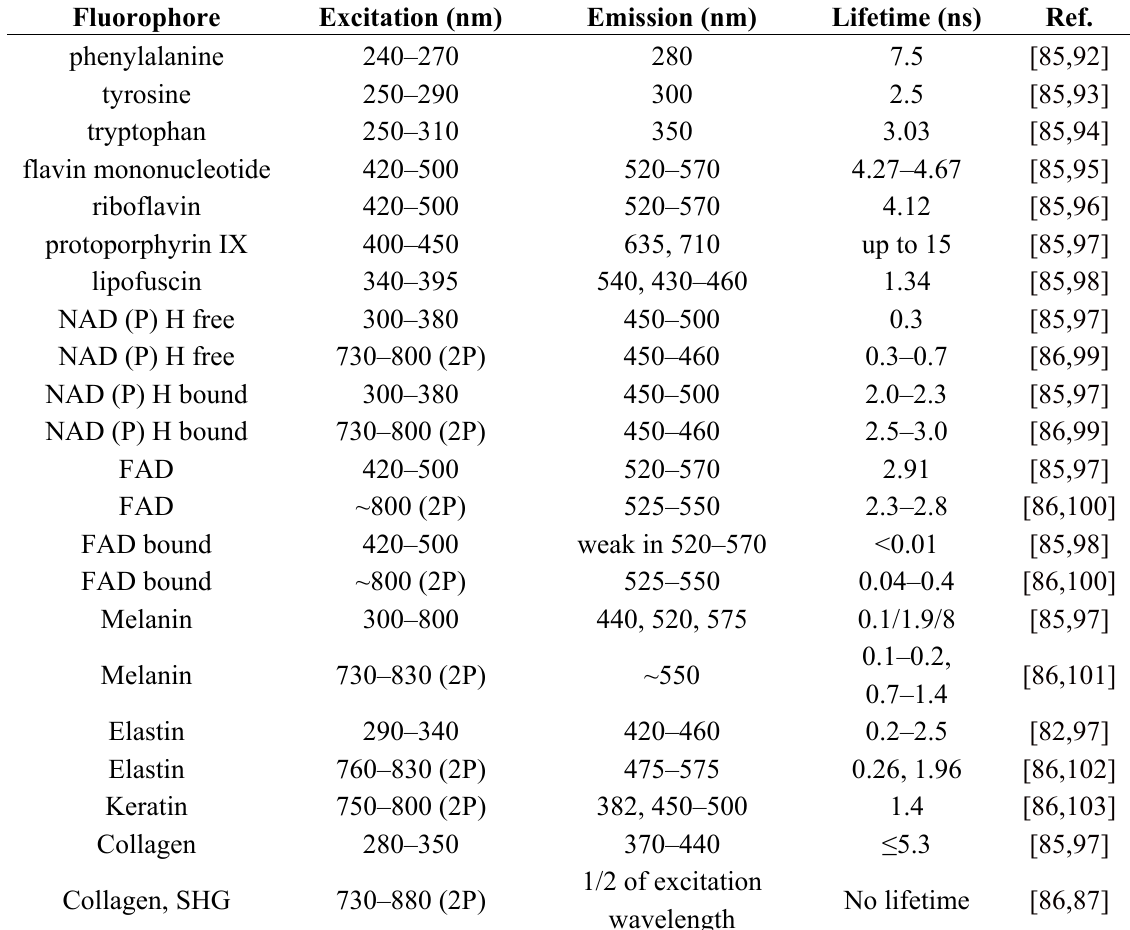
Table 4. Typical researches about the autofluorescence lifetime of the biological